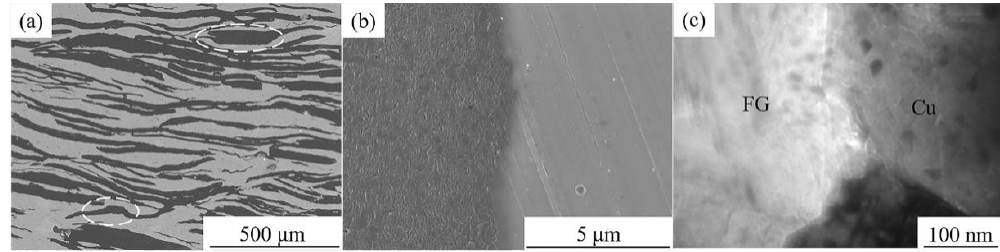
Figure 4. SEM images of ( a ) typical microstructure and ( b ) interface morphology, and ( c ) TEM micrograph of Cu-FG interface of 50 vol% FG/Cu composite.